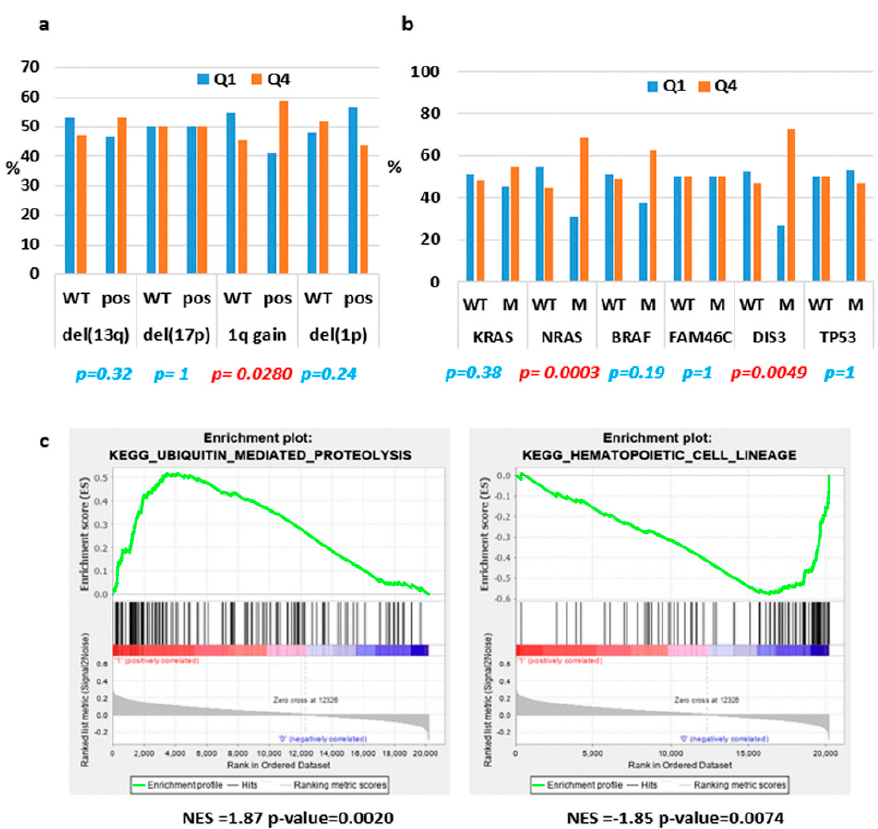
Figure 3. ST3GAL6-AS1 expression in CoMMpass database. ( a , b ) Histograms representing the occurrence of the indicated molecular features in the I and IV quartiles (Q1 and Q4) analyzed by the Fisher’s exact test; significant p-value are reported in red. ( c ) Enrichment plots of two selected gene sets detected by GSEA. The green curves show the enrichment score and reflect the degree to which each gene (black vertical lines) is represented at the bottom of the ranked gene list. NES: Normalized Enrichment Score.